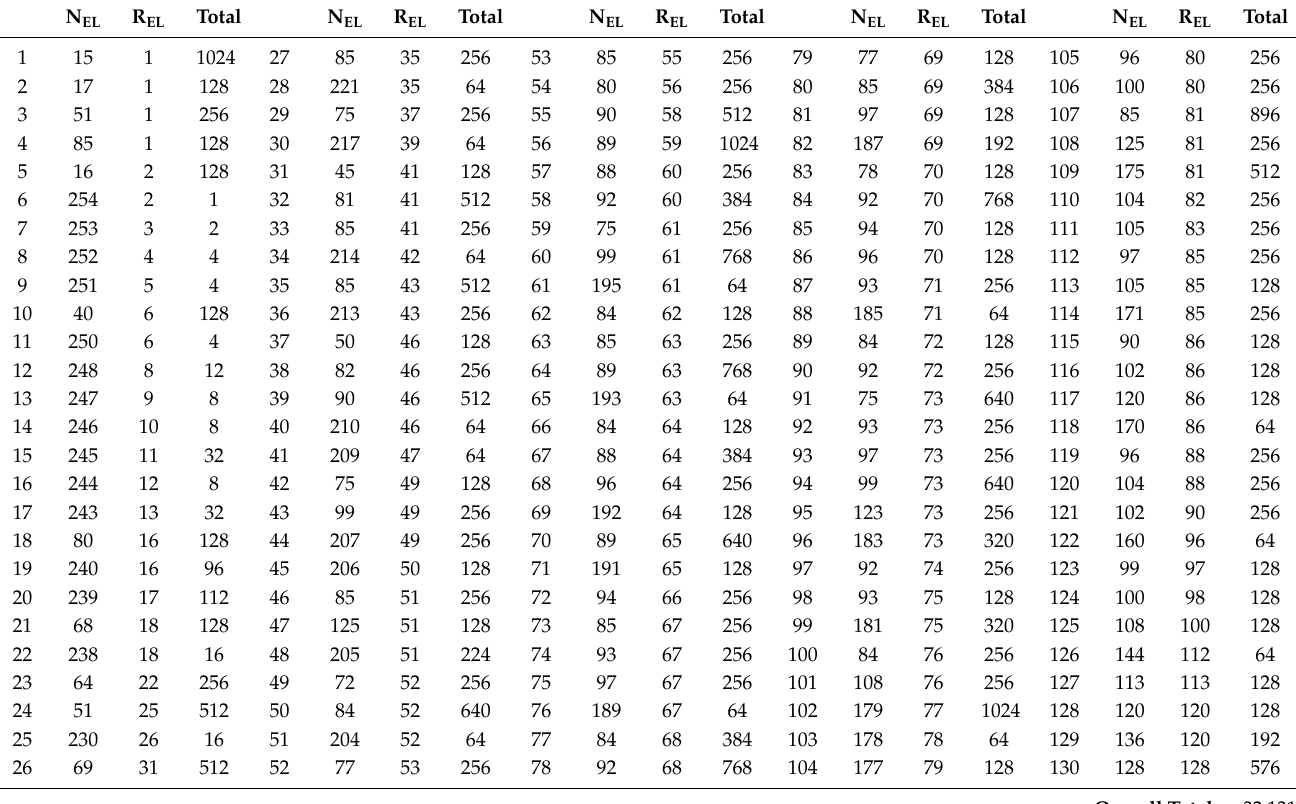
Table 5. Redundancy Analysis of Binomial Power